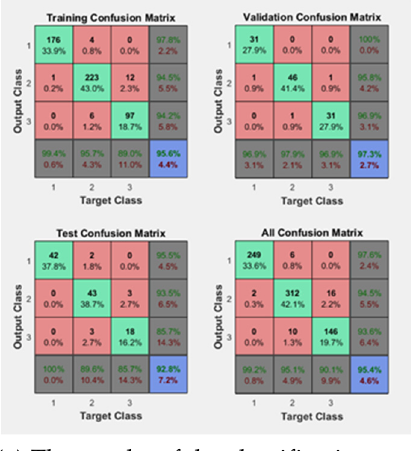
Figure 7. The results of the ANN.